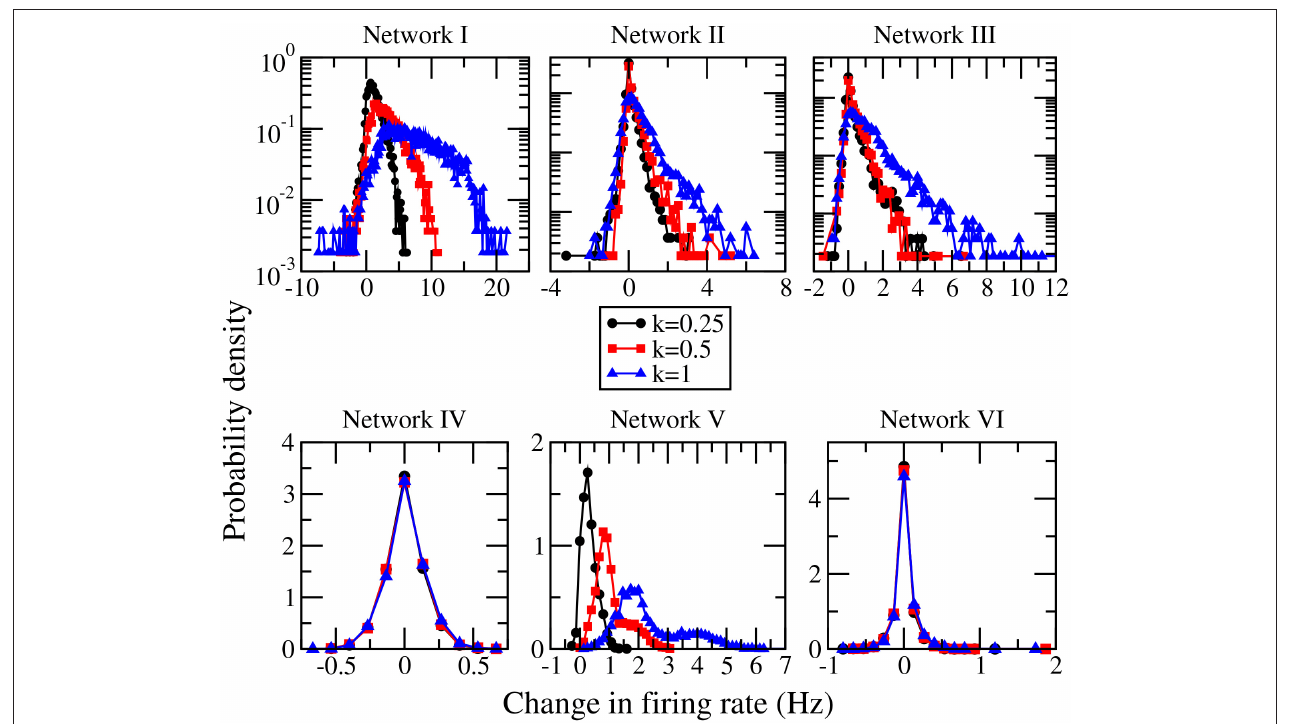
FIGURE 4 | Distributions of the change in firing rate for the three different levels of suppression of inhibition for networks I–VI.